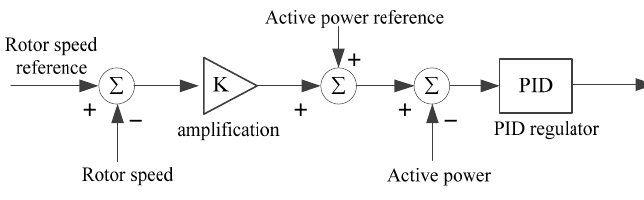
Figure 4. Transfer function block of the steam turbine governing system.